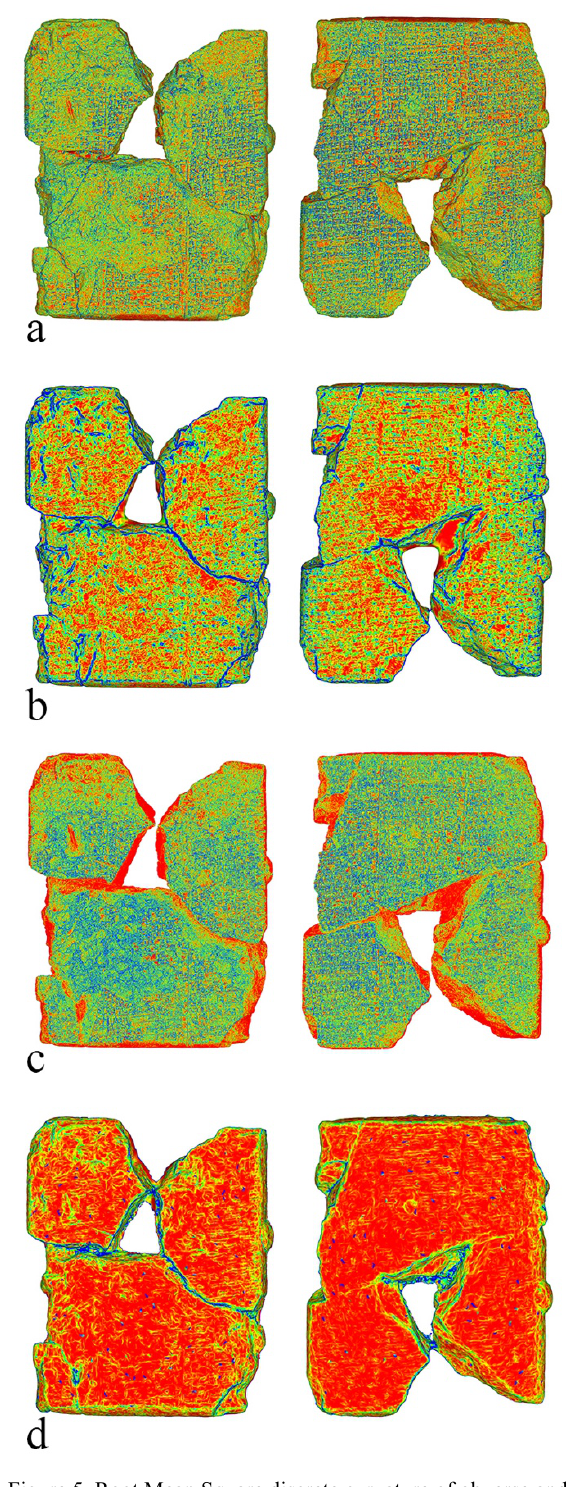
Figure 5. Root Mean Square discrete curvature of obverse and reverse sides of the 3D models of YBC 2178: a. structured light, b. triangulation laser scanner, c. photometric stereo, d. close-range photogrammetry.